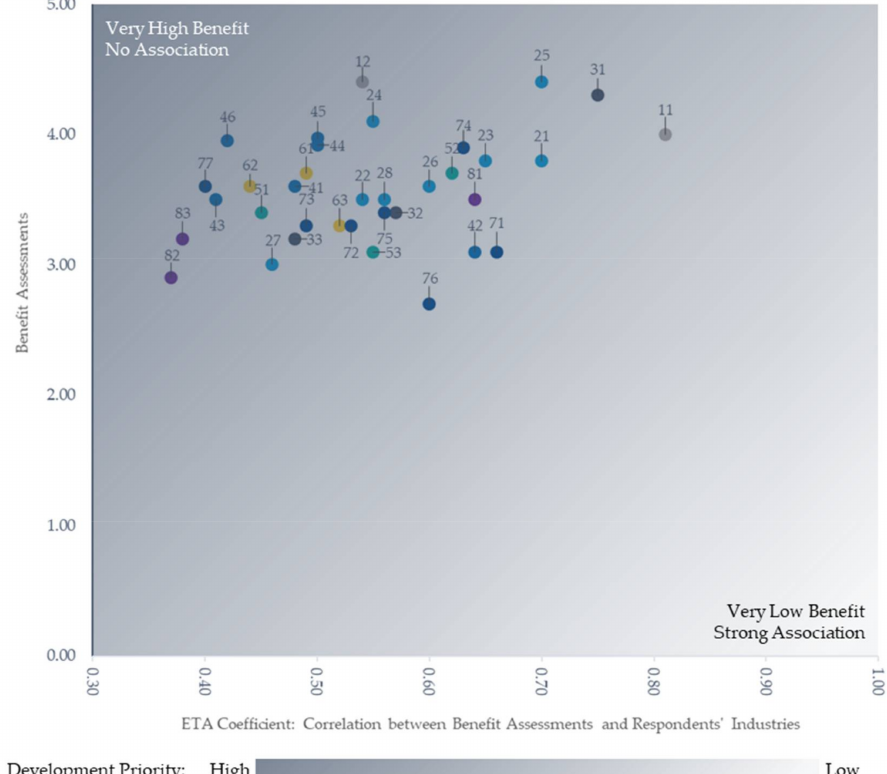
Figure 8. BIM uses’ benefit assessments and their respective correlation to the respondents’ industries as ETA coefficient ( n =